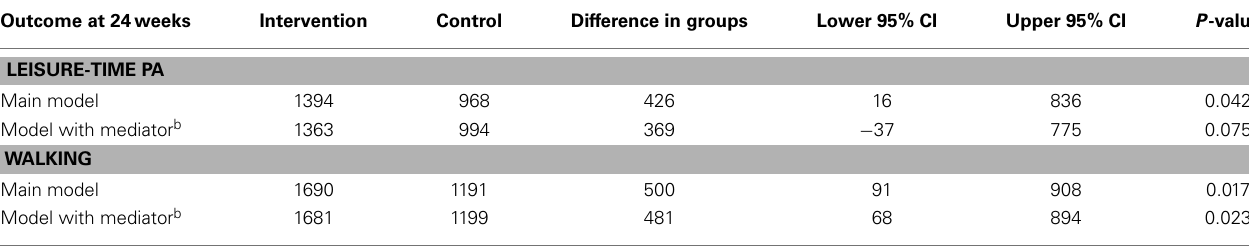
Table 1 |Treatment effects a with and without self-efficacy as the mediator